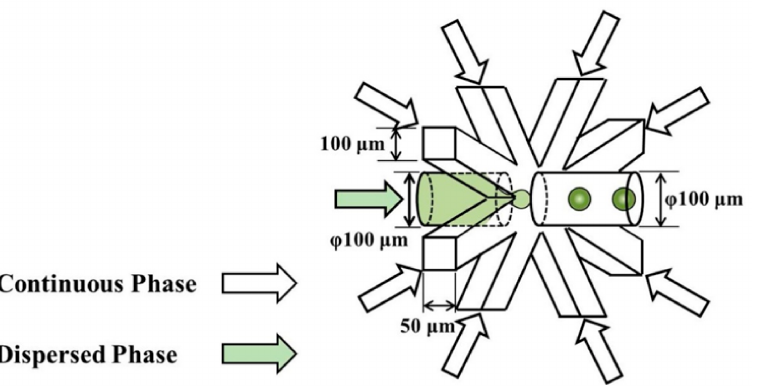
Figure 26. Schematics and dimensions of the microfluidic device designed by Nozaki et al. Reprinted from an open-access source